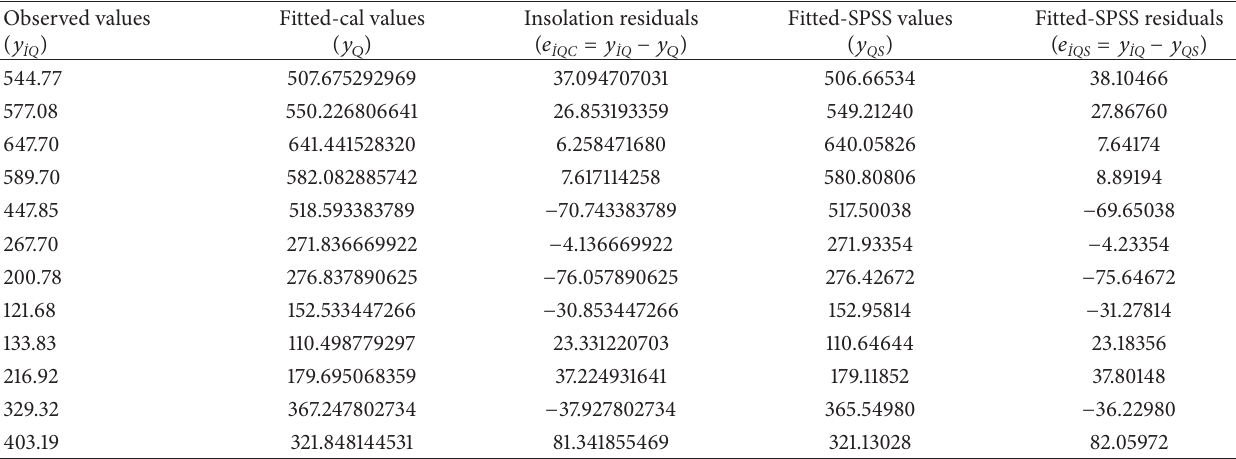
Table 6: The results and differences of the regression equation with isolation level as the dependent variable. Observed values 544.77